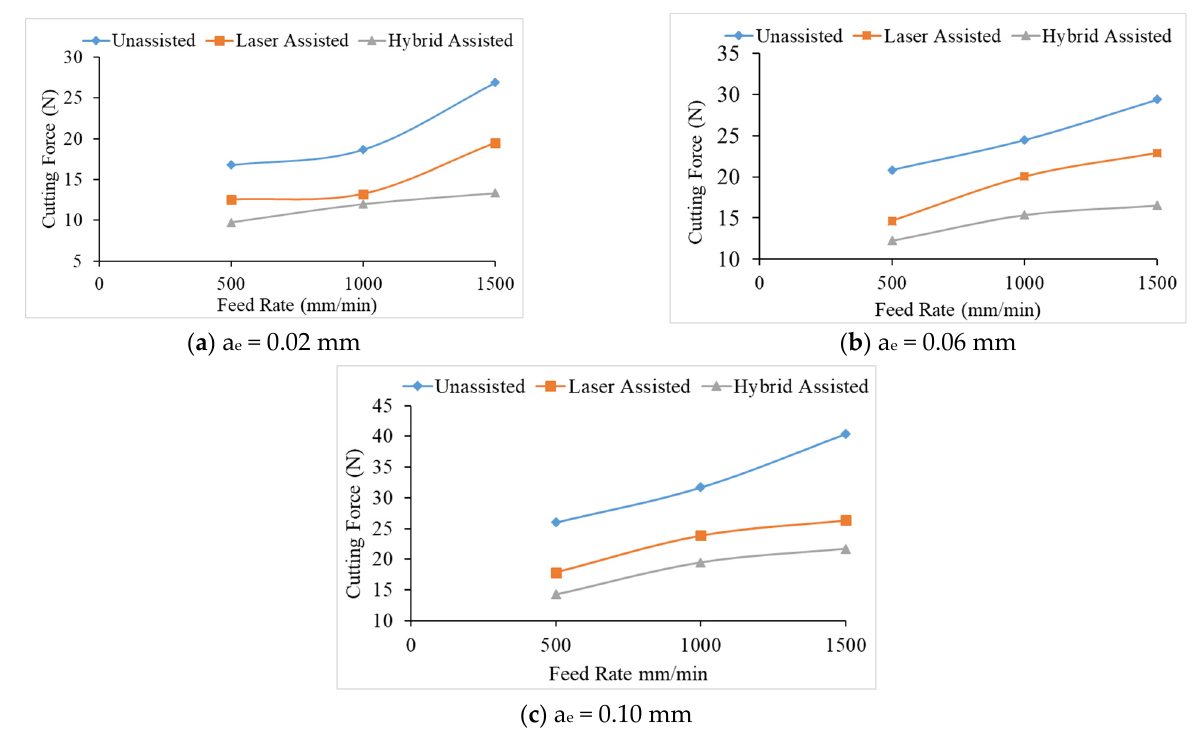
Figure 9. The relationship between the feed rate and cutting force under different the radial depths of cutting for unassisted, laser-assisted, and hybrid-assisted systems. In total, 81 experiments were performed (27 experiments for each assistance system). The average cutting force values of three experiments are reported in Table 7.